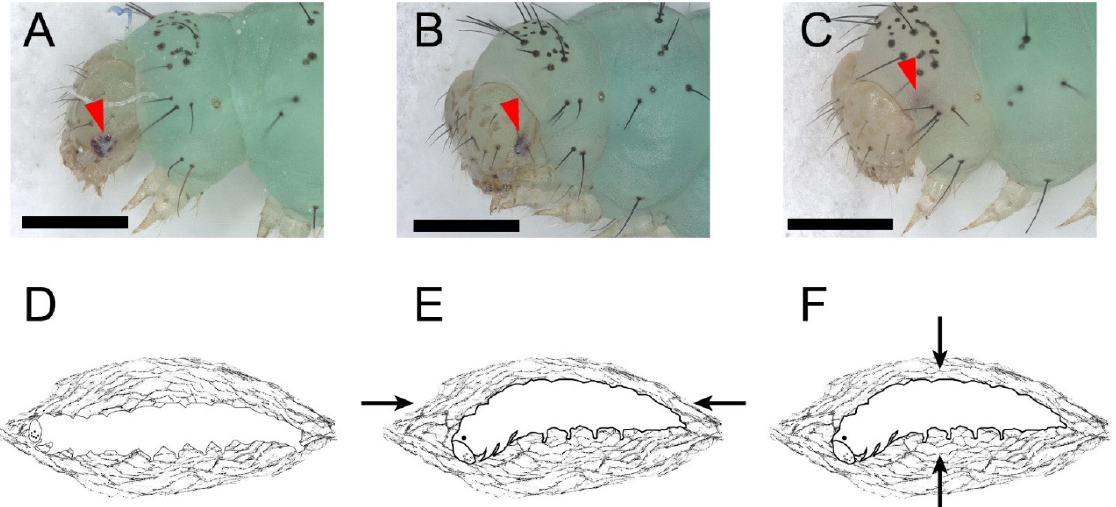
Figure 3. The larval–pupal metamorphosis and the tanning before the eclosion of P. xylostella . The full red arrowheads point to the stemmata pigment spots. Scale bar = 500 μ m. n = 36. ( A , D ) Stage II: cocooning. There were a white bars among the stemmata on the head capsules of fourth instar larvae. There were no significant changes in the stemmata and the white bar at this stage. ( B ) Stage III: Head capsule slip. The head capsule slipped anteriorly and ventrally after cocooning. The stemmata pigments and the white bar progressively faded. ( C ) Stage IV: Stemmata moved out of the margin of the head capsule, merged as one pigment spot, and distinctly faded while the white bar was left inside the head capsule and almost vanished. ( E ) Pre-ecdysis I at stage IV. The arrows show the anterior-posterior contractions of the prepupa. ( F ) Pre-ecdysis II at stage IV. The arrows show the dorsal-ventral contractions of the prepupa.